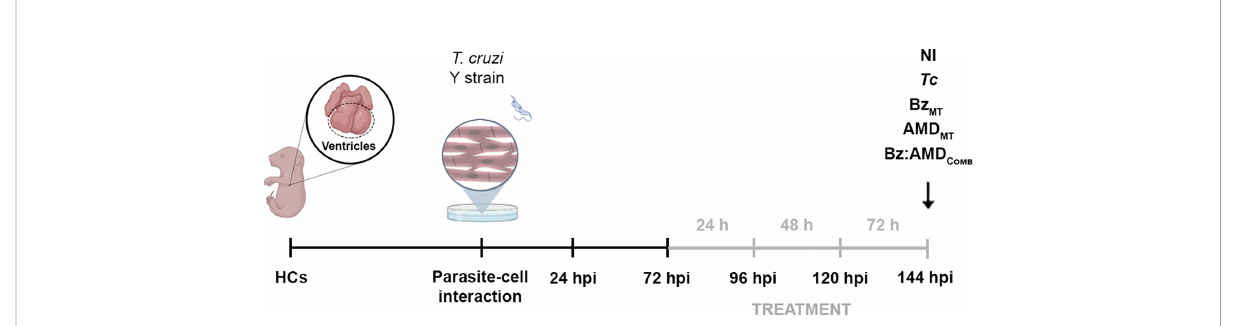
FIGURE 1 Experimental design of the treatment with Bz, AMD or their combination of T. cruzi -infected mouse embryo heart cells (HCs). Cell cultures were exposed to BT of T. cruzi for 24 h and then washed to remove noninternalized parasites. Treatment started at 72 hpi and was performed for 24, 48 and 72 h (gray line). Treatment for 72 h was de fi ned for the combined therapy assays. At this time (144 hpi), HCs T. cruzi -infected ( Tc ) or non-infected (NI) were treated with the compounds at concentrations corresponding to the IC 50 /72 h in monotreatment (Bz MT and AMD MT ) and in combination at a ratio of 1:4 (Bz:AMD Comb ). The illustration is created with Biorender.com